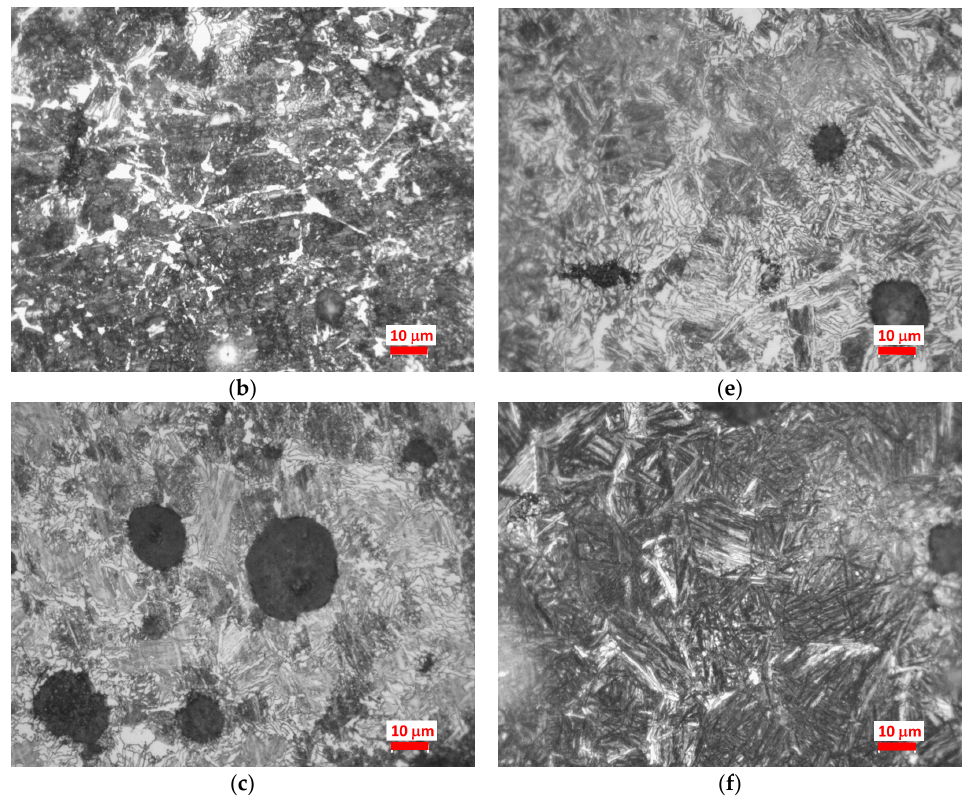
Figure 3. Optical images of the microstructures of Alloy O ( a – c ) and Alloy M ( d – f ) samples austempered at 350 °C ( a , d ), 320 °C ( b , e ), and 290 °C ( c , f ) (1000×, 2% nital etched).